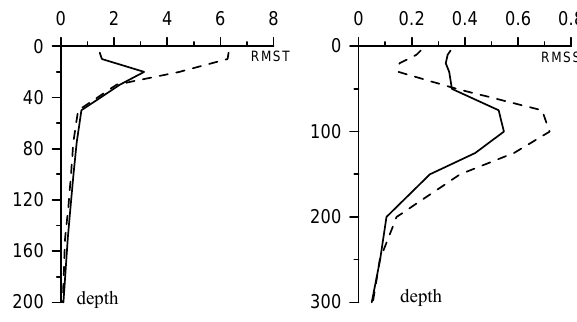
Figure 12 Standard deviation of the differences between simulated and measured fields as a function of depth (solid lines), and the natural variability of the same fields (dash lines). Figure 10 Comparison of the simulated (blue line) and measured (red line) temperature profiles in the upper 70 m during the shoaling of the mixed layer.